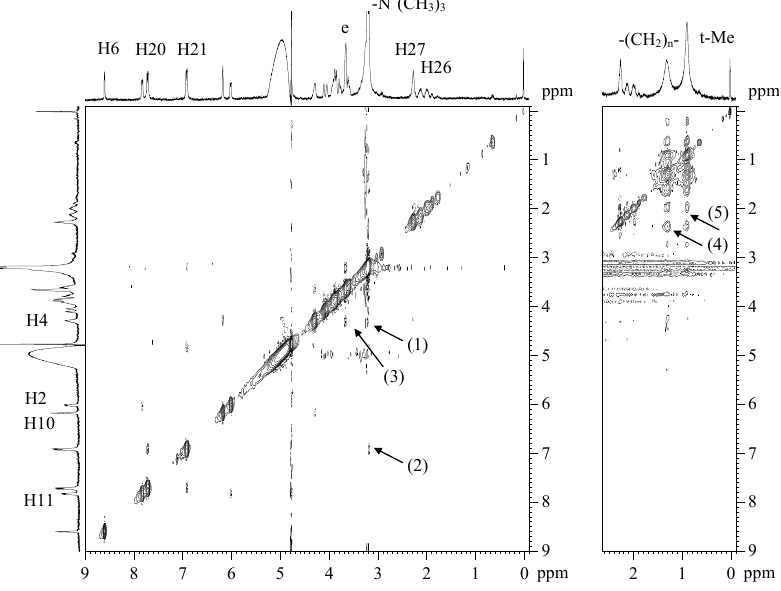
Figure 6. 2D NOESY spectra of L DPPC/AraC/MTX liposomes obtained at 25 °C ( left panel) and at 47 °C ( right panel).